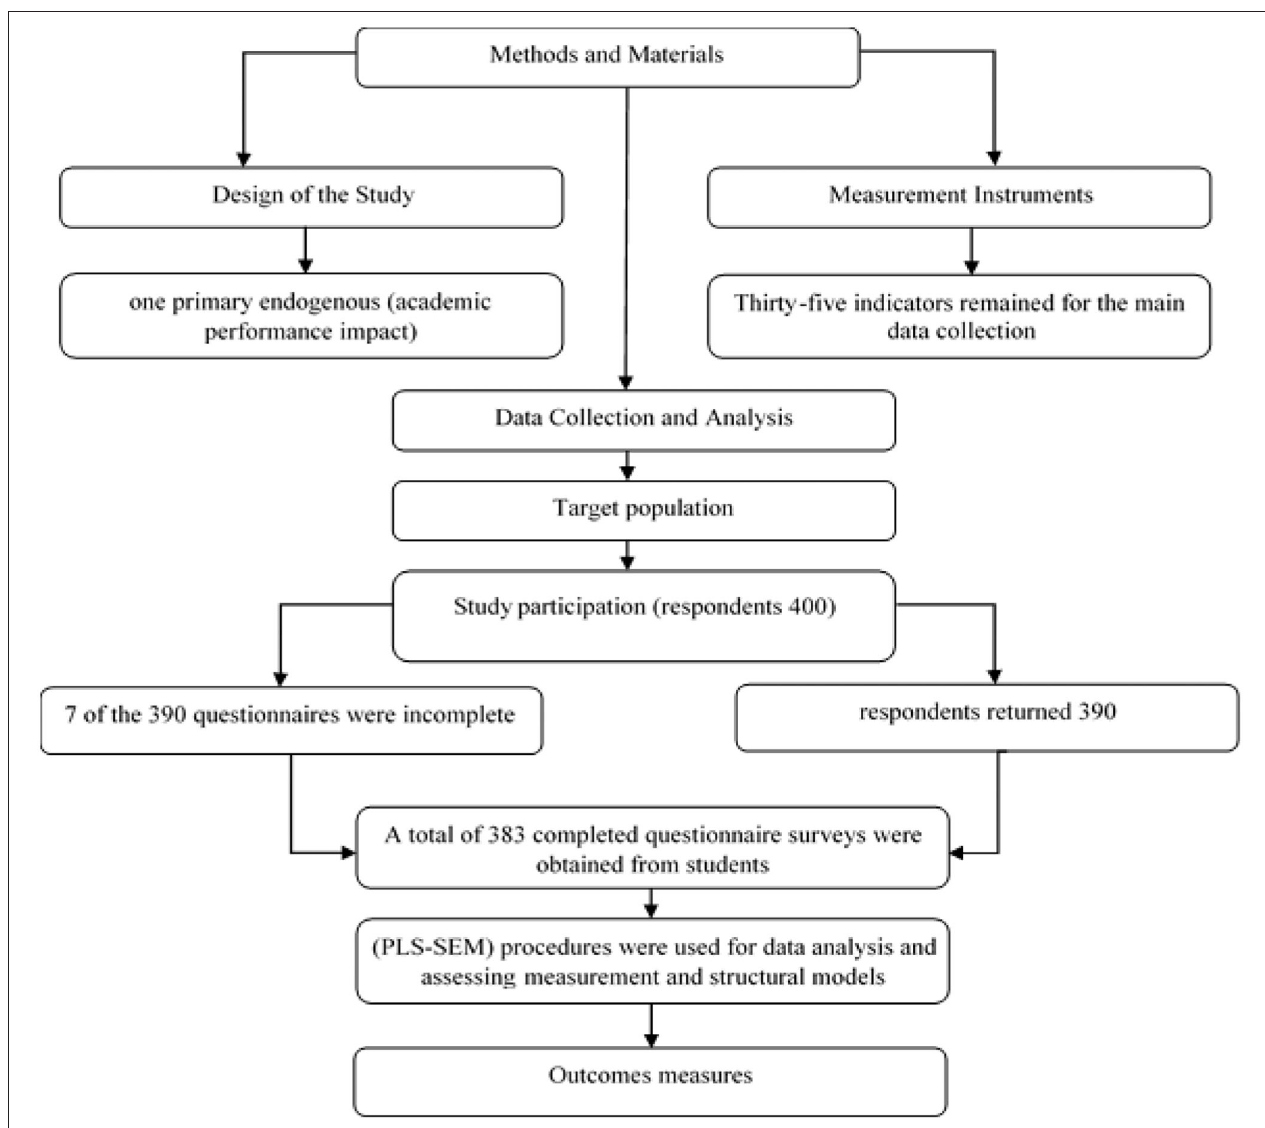
FIGURE 2 | Diagram for methods and